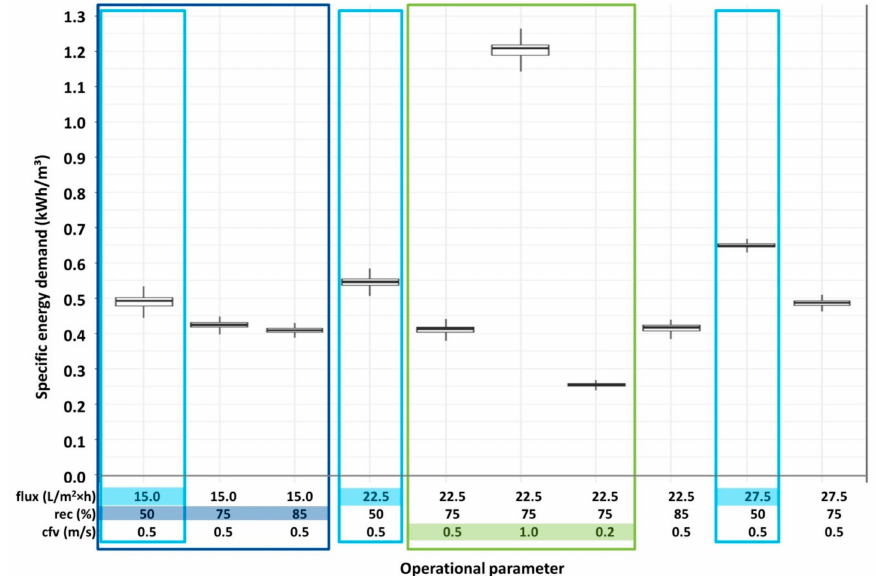
Figure 3. Specific energy demand (kWh/m 3 permeate) for different operational parameter (drinking water as feed source), light blue: increase of flux at constant rec and cfv, dark blue: increase of recovery at constant flux and cfv, green: increase of cfv at constant flux and rec.